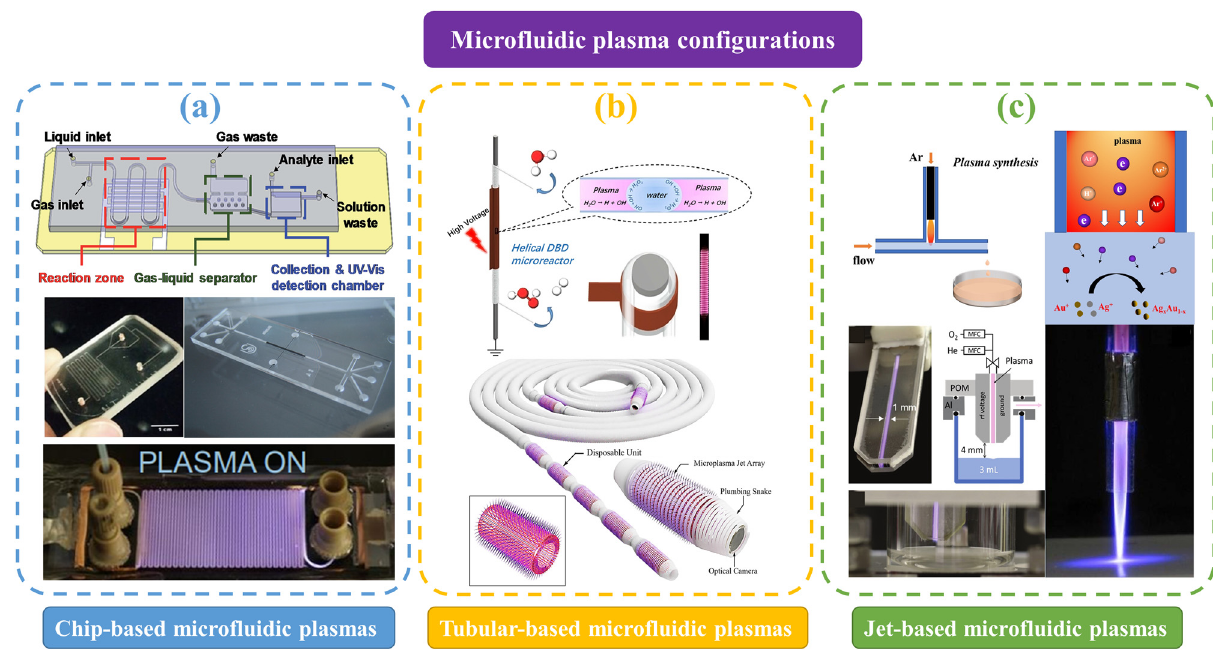
Figure 2: Representative micro fl uidic plasma con fi gurations: ( a ) chip - based micro fl uidic plasma, ( b ) tubular - based micro fl uidic plasma, and ( c ) jet - based micro fl uidic plasma. ( a ) Reprinted with permission from [ 26 – 28 ] , Copyright 2018 The Royal Society of Chemistry,